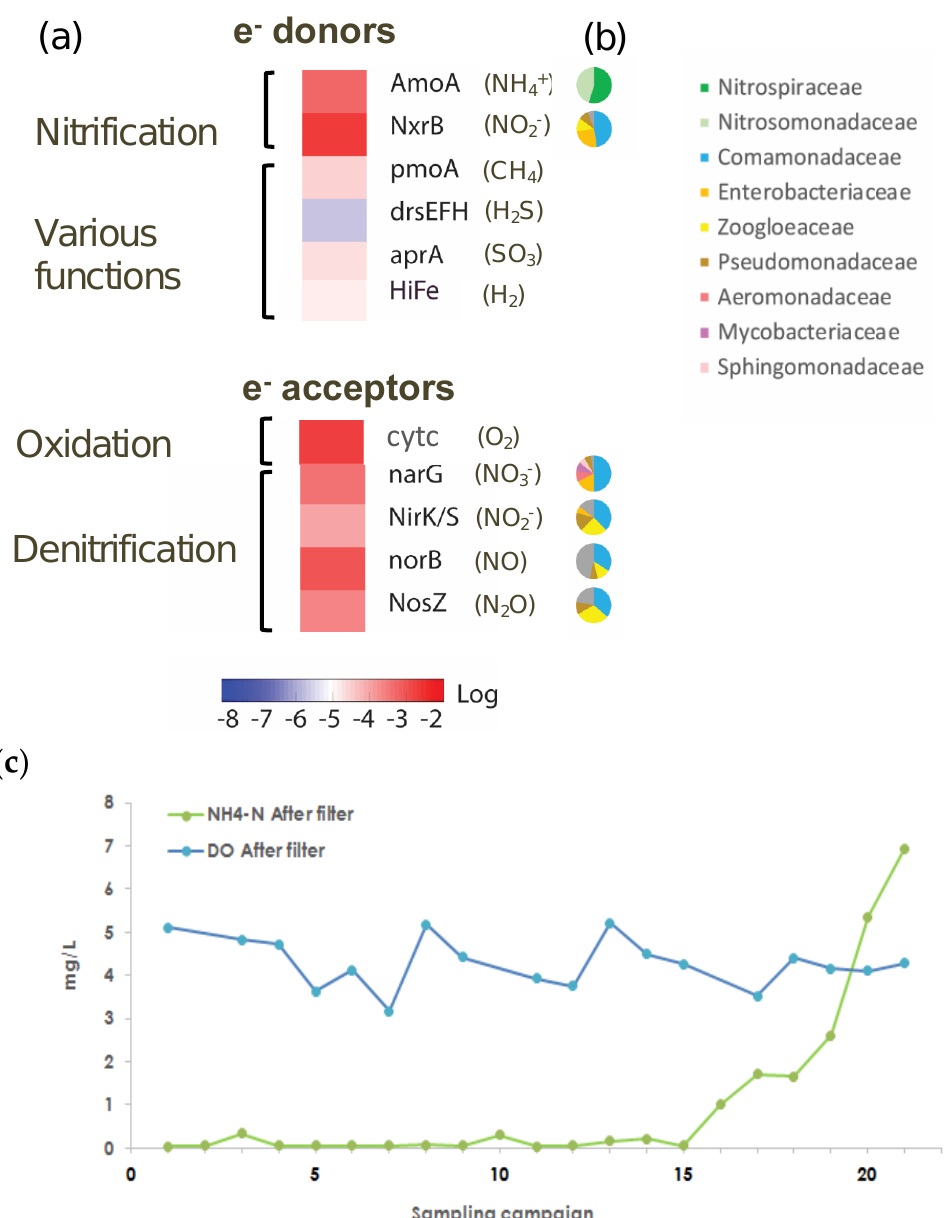
Figure 4. Log-transformed relative abundances of the marker genes of enzymes involved in nitrification, denitrification, and other metabolic pathways in the biofilter while H 2 O 2 was added with various electron donors and acceptors ( a ). For each functional gene, the composition of classified genera is presented ( b ). Concentrations of ammonia and oxygen in the system outlet ( c ).